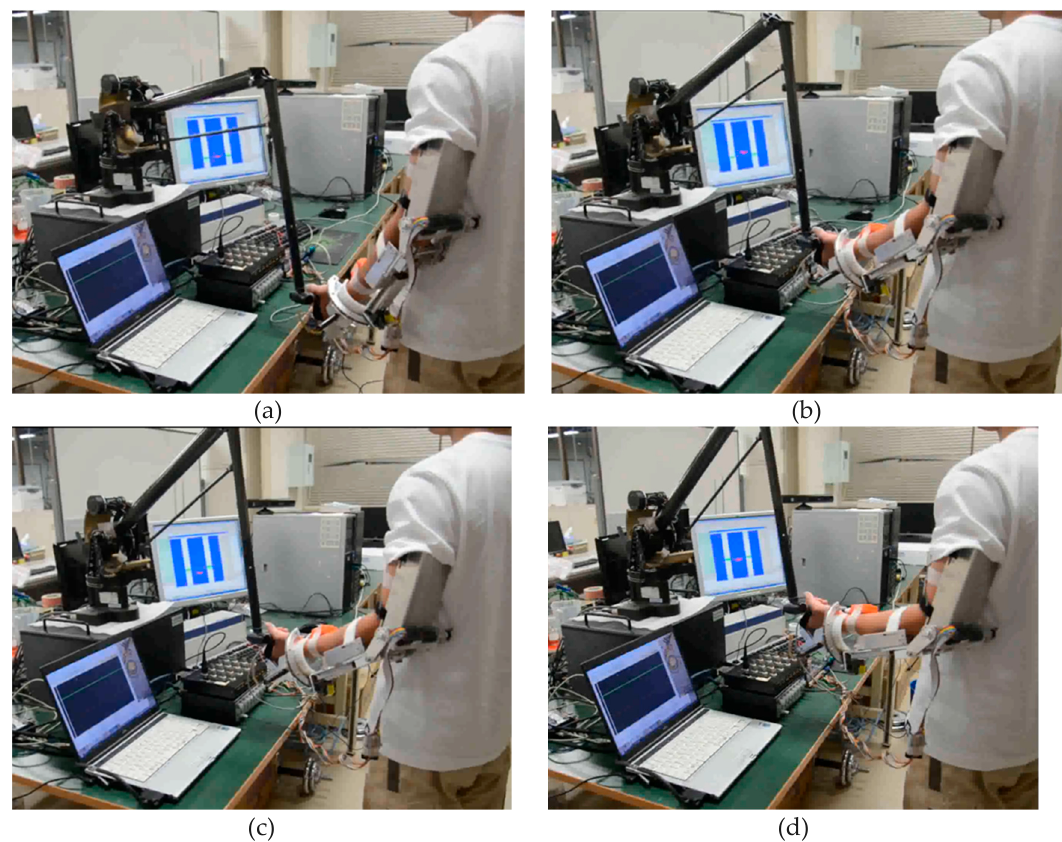
Figure 11. A subject is performing the bilateral training. ( a ) Phase 1, the affected arm operates the handle of the Phantom while synchronously moving together with the unaffected limb to the target position. ( b ) Phase 2, the two arms reach the directed position. ( c ) Phase 3, the target object will move to a random position within the moving ability of patients. ( d ) Phase 4, the two arms move to the renewed position to undergo the next round of training.